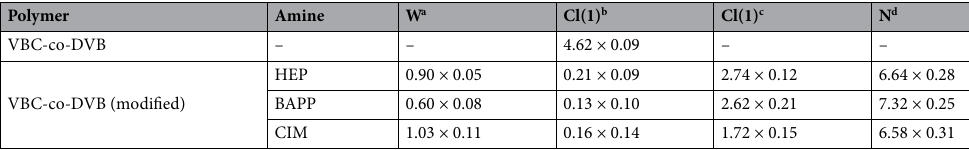
Table 1. Characteristics of the polymeric matrices for the pNCs with ReNSs. a H 2 O regain [g g −1 ] b